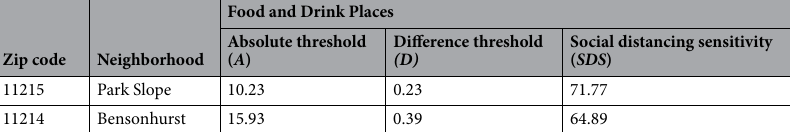
Table 3. Neighborhood comparison: Descriptive statistics of POI-level sensitivity measurements for food and beverage places in a high sensitivity neighborhood (Park Slope) and a low sensitivity neighborhood